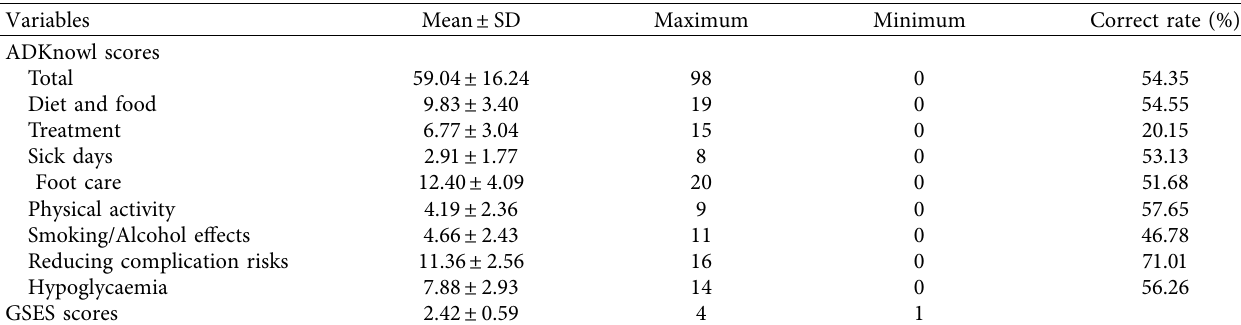
Table 2: The audit of diabetes knowledge (ADKnowl) scores and the GSES